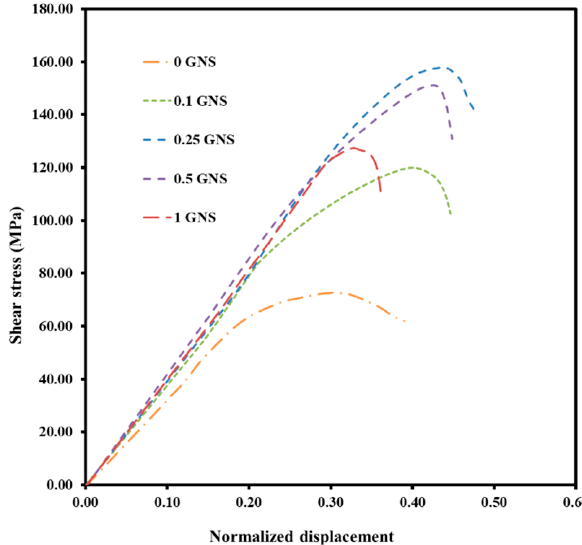
Figure 9. Engineering shear stress vs. normalized displacement of fabricated samples with different GNS weight percentages.